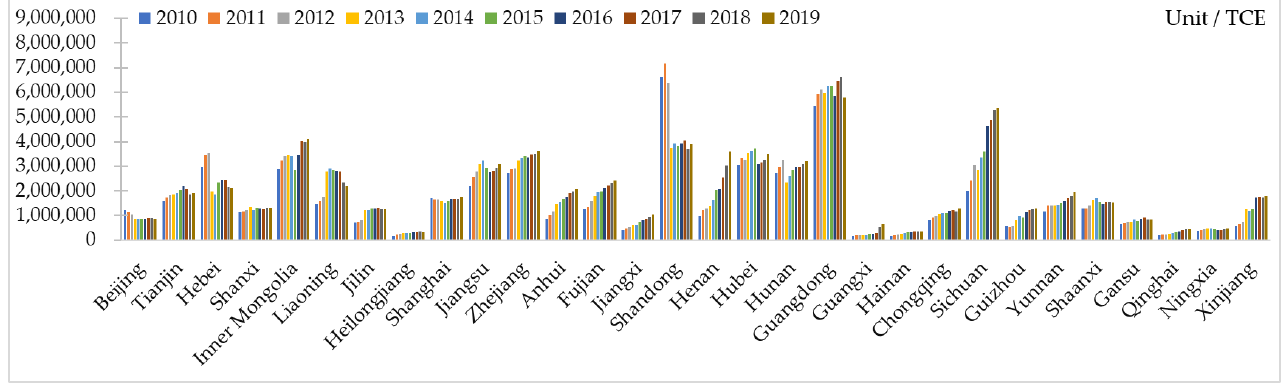
Figure 5. Temporal change characteristic of ECA on construction industry from 2010 to 2019.